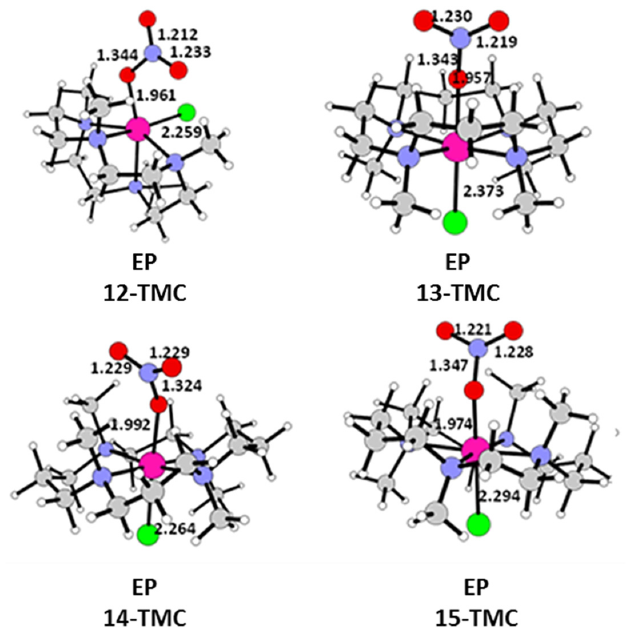
Figure 5. Optimized structures of EP species for all the investigated ligands along with the main geometrical parameters. Selected bond lengths are in Å. Oxygen (red), chlorine (green), carbon (silver), nitrogen (azure), chromium (hot pink).